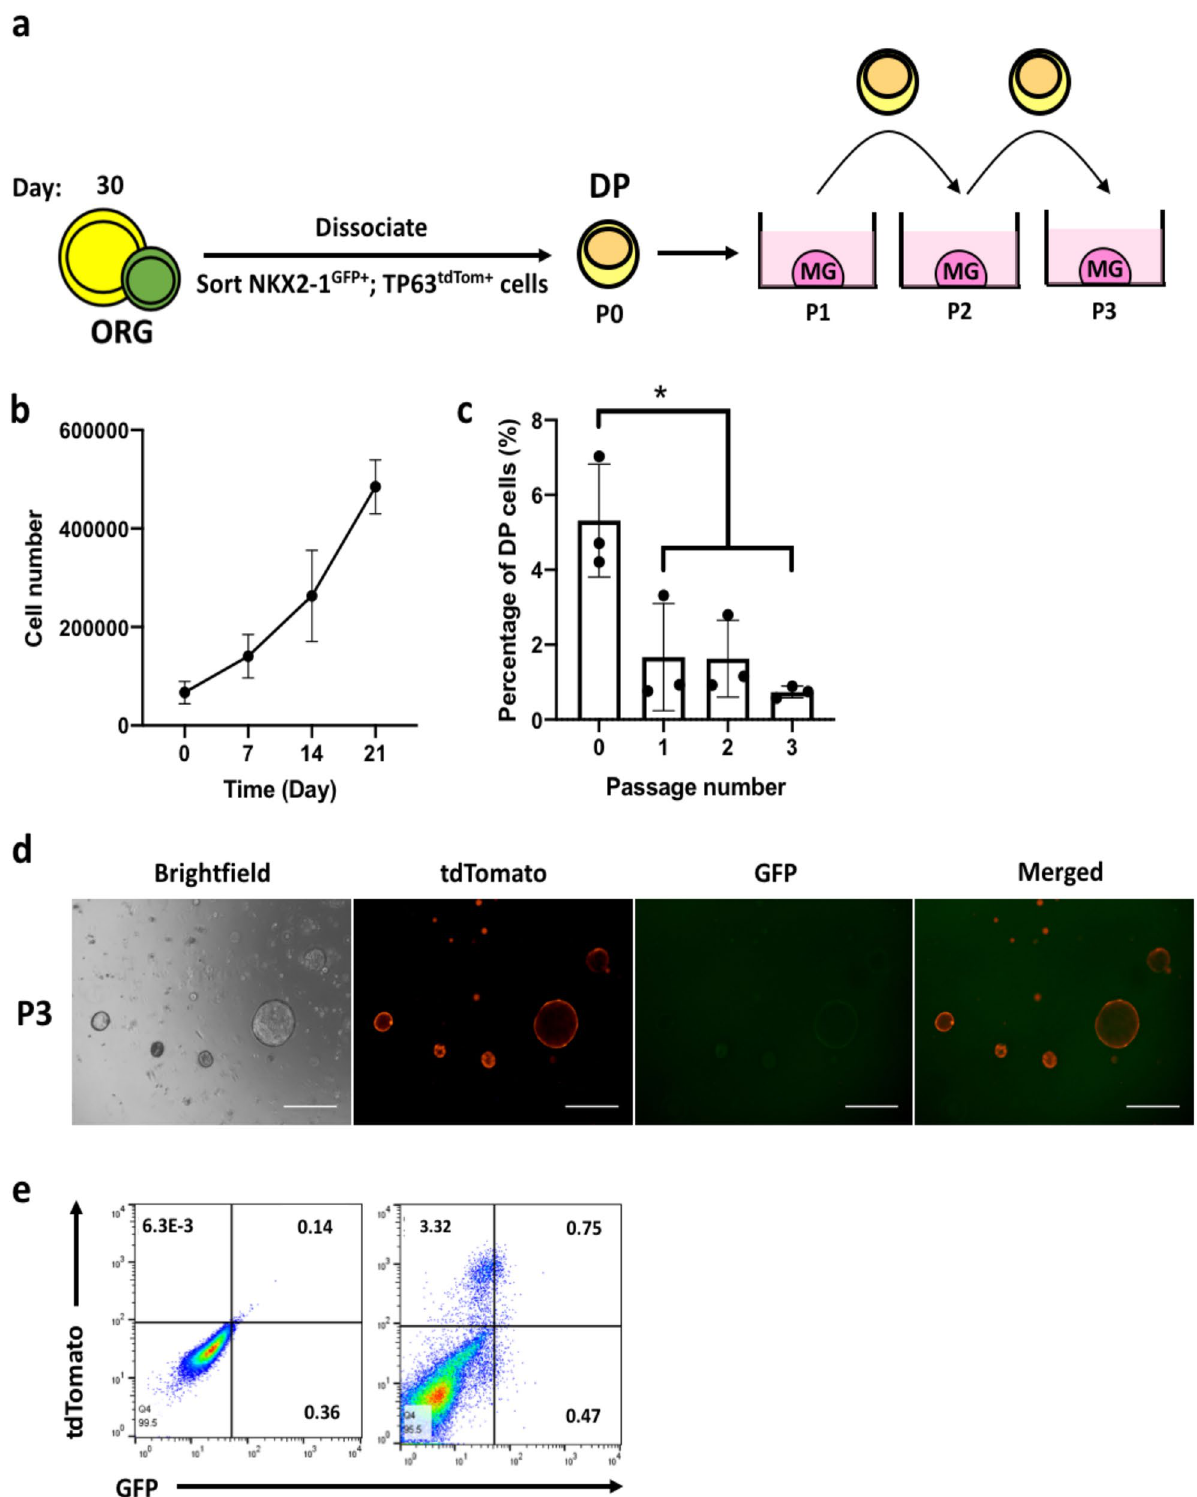
Figure 7. DP cells are proliferative and are capable of self-renewal. ( a ) Schematic of experimental setup. DP cells were serially passaged up to 3 passages. ORG: lung organoid; DP: double positive; MG: Matrigel. ( b ) Growth kinetics of DP cells at passage number 1 (P1). n = 3. ( c ) DP cells quantified at passage numbers P0, P1, P2 and P3 using flow cytometry. n = 3. ( b , c ) were made and statistical analyses were done using GraphPad Prism 8.0 (GraphPad Software Inc., San Diego, CA, USA) (www.graph pad.com). ( d ) Representative images of organoids derived from DP cells at P3. Scale bars indicate 500 µm. ( e ) Representative flow cytometry dot plot of dissociated organoids derived from DP P3